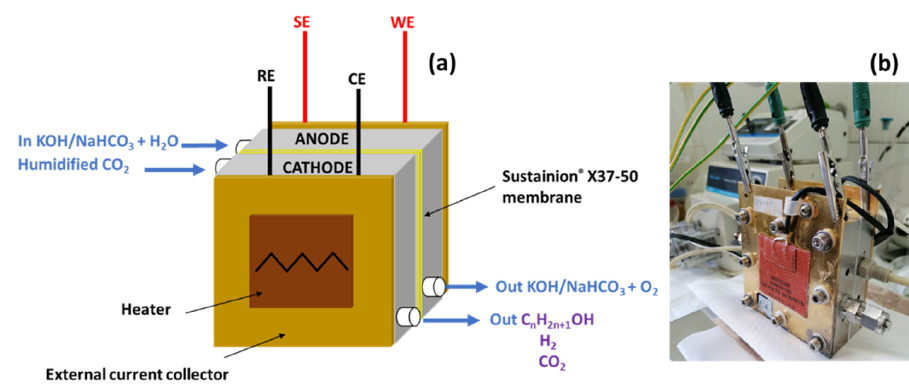
Figure 5. Scheme of the electrochemical process used for CO 2 -H 2 O coelectrolysis ( a ), single-cell unit ( b ).